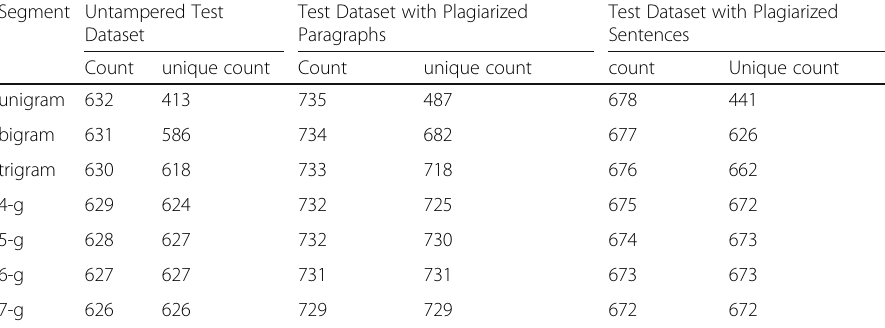
Table 8 Characteristics of the test dataset Segment Untampered Test Dataset